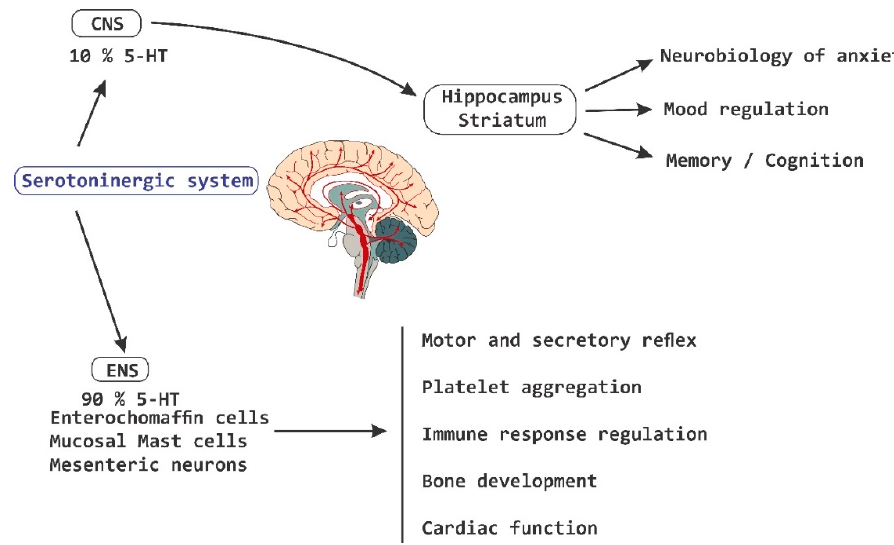
Figure 3. Serotoninergic system. The serotoninergic system is involved in the pathogenesis of diseases at the intestinal level, as well as in the regulation of different functions at a systemic level, which includes the regulation of memory processes, cognition and humor, among others. CNS, central nervous system; 5-HT, serotonin; ENS, enteric nervous